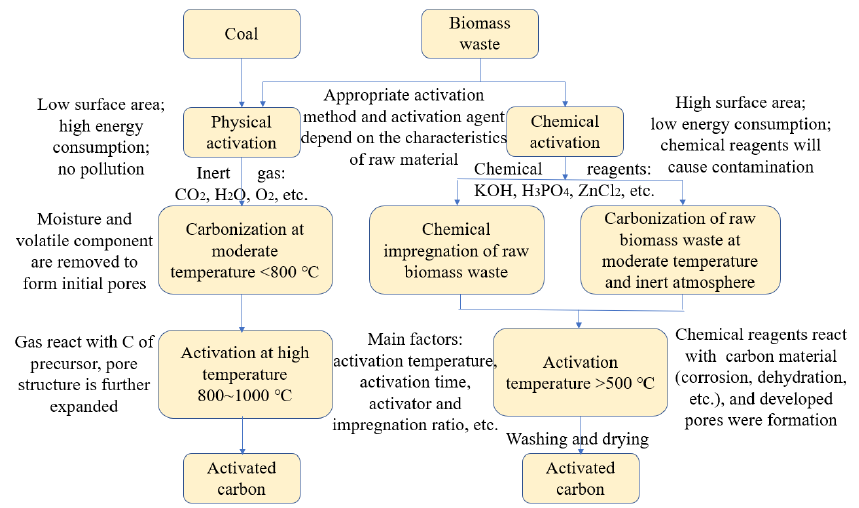
Figure 4. The production of activated carbon by physical and chemical activation (based on [97]). Activation Time